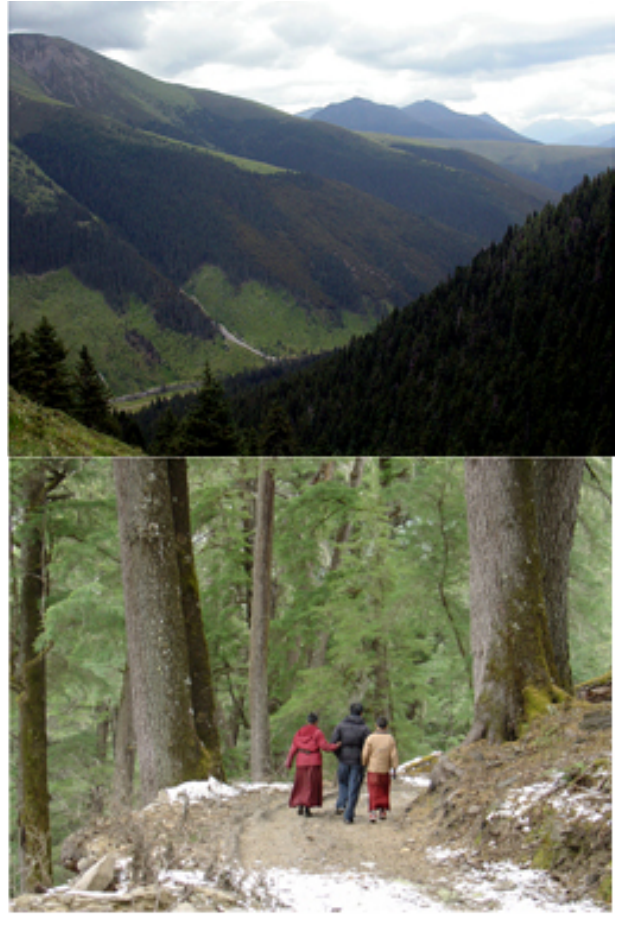
Fig. 4. Photo on the left shows a sacred mountain (foreground) with dense primary forest and the other side of the non-sacred mountain (background) in the valley with commercially logged patches; photo on the right shows the big conifer trees on a sacred mountain in Ganzi Prefecture, Sichuan Province, China.